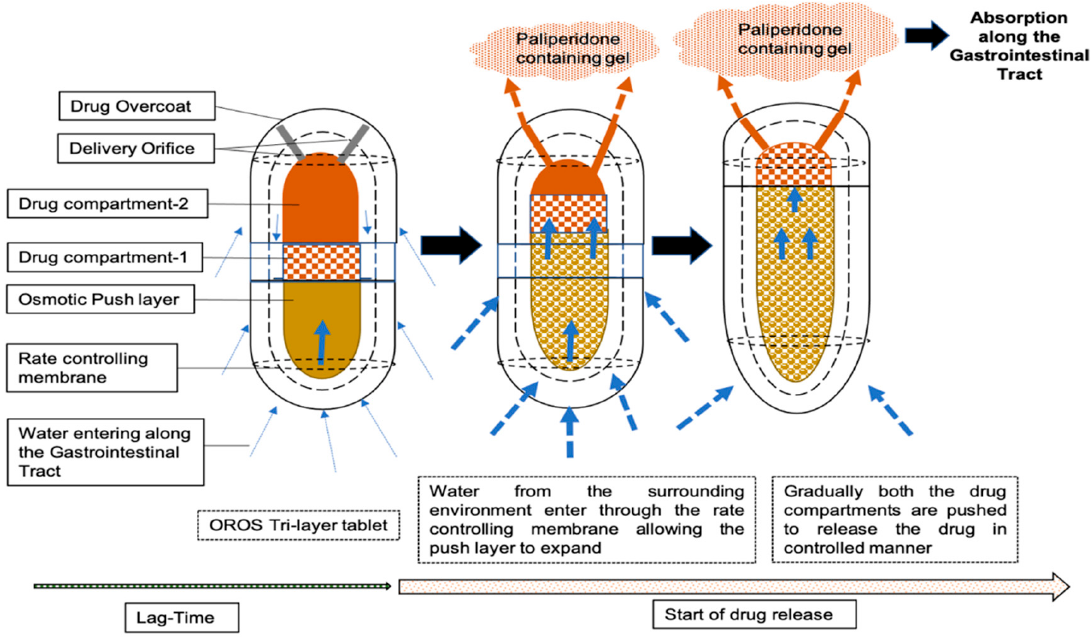
Figure 1. A schematic diagram describing the mechanism of release of PAL from tri ‐ layer OROS formulation Invega ® for absorption along the GI tract.